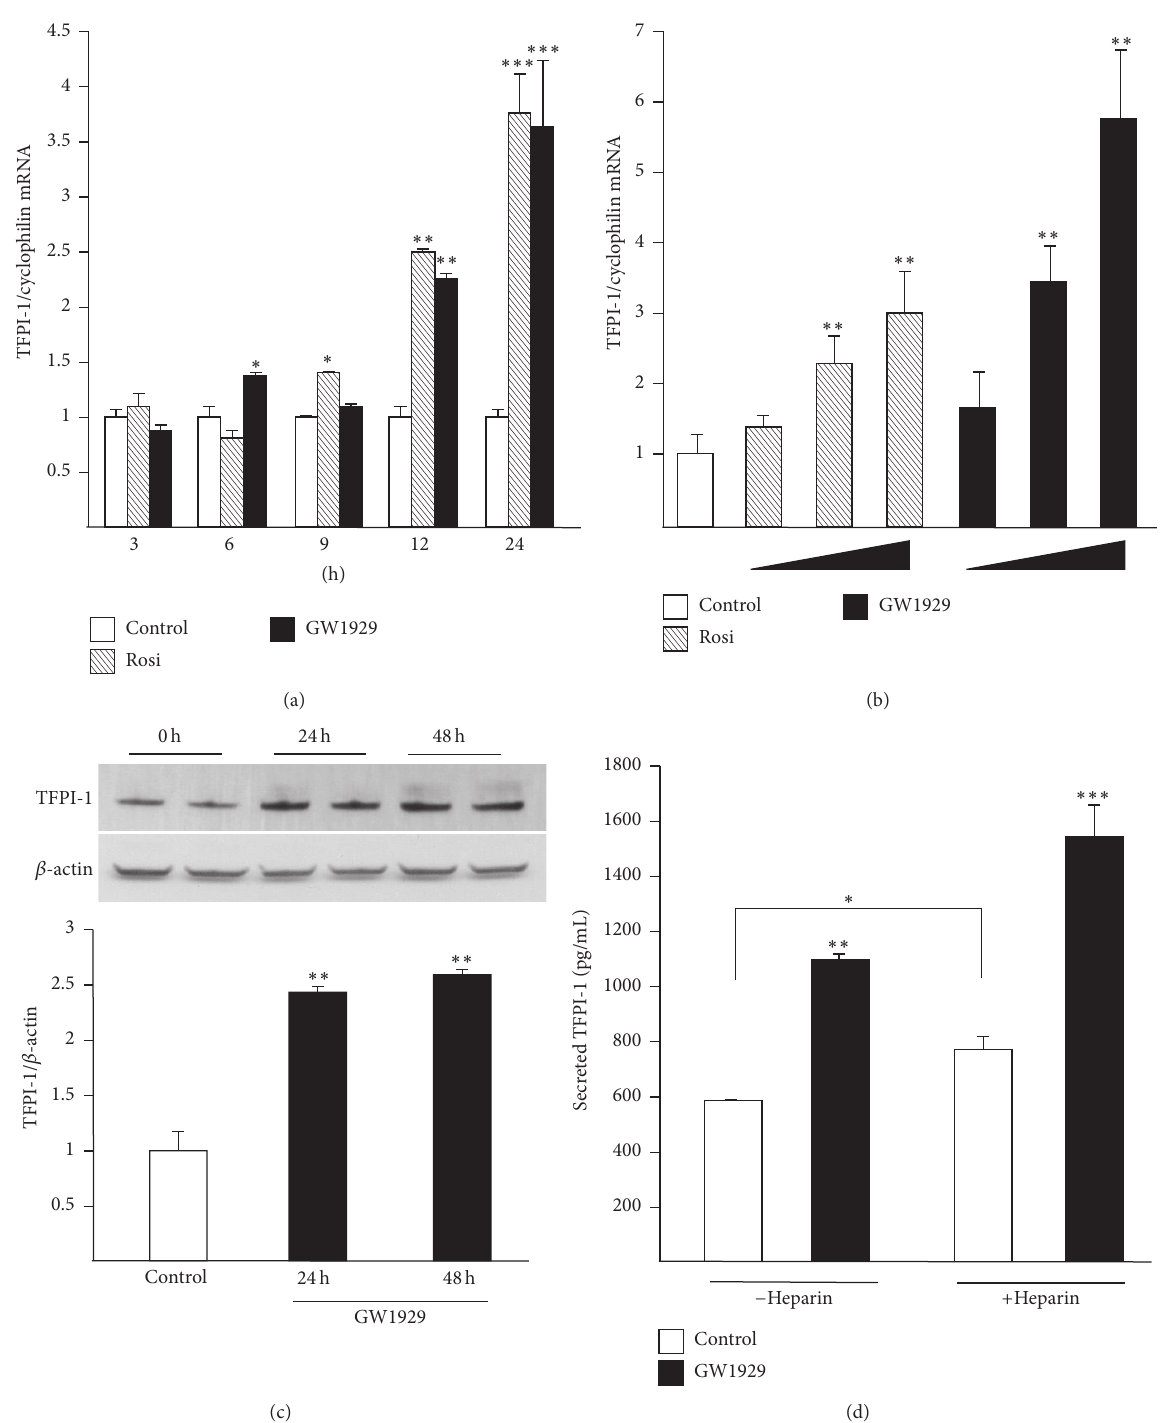
Figure 2: Expression of TFPI-1 is enhanced by PPAR 𝛾 activation in primary human macrophages. Differentiated macrophages were treated in the absence or in the presence of GW1929 (600nM) and rosiglitazone (Rosi, 100 nM) for 3 h, 6h, 9 h, 12h, or 24h (a) or with increasing concentrations of Rosi (50nM, 100nM, and 1 𝜇 M) or GW1929 (300 nM, 600 nM, and 3 𝜇 M) for 24 h (b). Total RNA was extracted and TFPI-1 mRNA levels were measured by Q-PCR and normalized to those of cyclophilin. (c) Differentiated macrophages were treated with GW1929 (600 nM) for 24 h and 48 h and TFPI-1 protein expression analyzed by western blot. TFPI-1 bands intensity was measured and normalized to those of 𝛽 -actin. (d) Differentiated macrophages were treated with GW1929 (600nM) in the absence or in the presence of heparin (1U/mL), as described above. Culture media were collected and TFPI-1 protein release measured by ELISA. Results are expressed as the mean value ± SD of triplicate determinations, representative of three independent experiments. Statistically significant differences are indicated ( ∗ 𝑝 < 0.05 , ∗∗ 𝑝 < 0.01 , and ∗∗∗ 𝑝 < 0.001